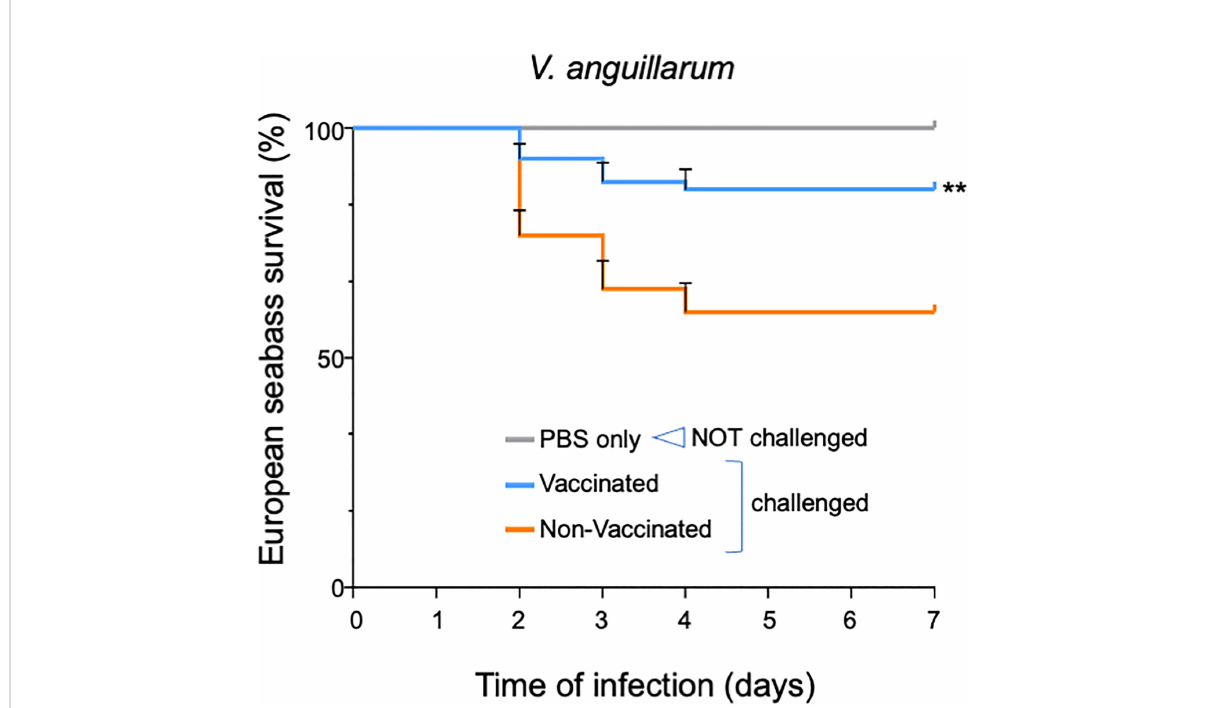
FIGURE 5 European seabass survival to V. anguillarum infection after oral vaccination with OmpK carrying spores. Survival Kaplan-Meyer survival curves of European seabass juveniles upon challenge with V. anguillarum after being orally vaccinated for 1 month with feed containing spores bearing the OmpK antigen fused to CotY (CRS220, CotY-H6-OmpK). Non-vaccinated fi sh and non-challenged fi sh (PBS only) were used as positive and negative control groups, respectively. Fish were monitored for 15 days. Data are represented as mean ± standard deviation of three independent biological experiments. Signi fi cant differences are highlighted by asterisks ** ( p